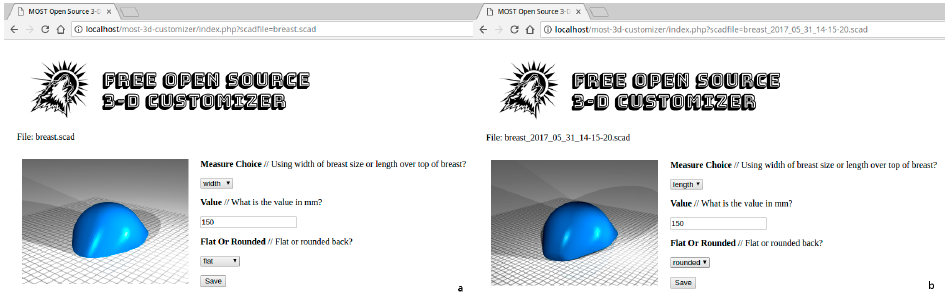
Figure 6. The prosthetic breast model customizable in size on the Free Open Source 3-D Customizer with different options ( a ) for flat width measurement and ( b ) for rounded length measurement.